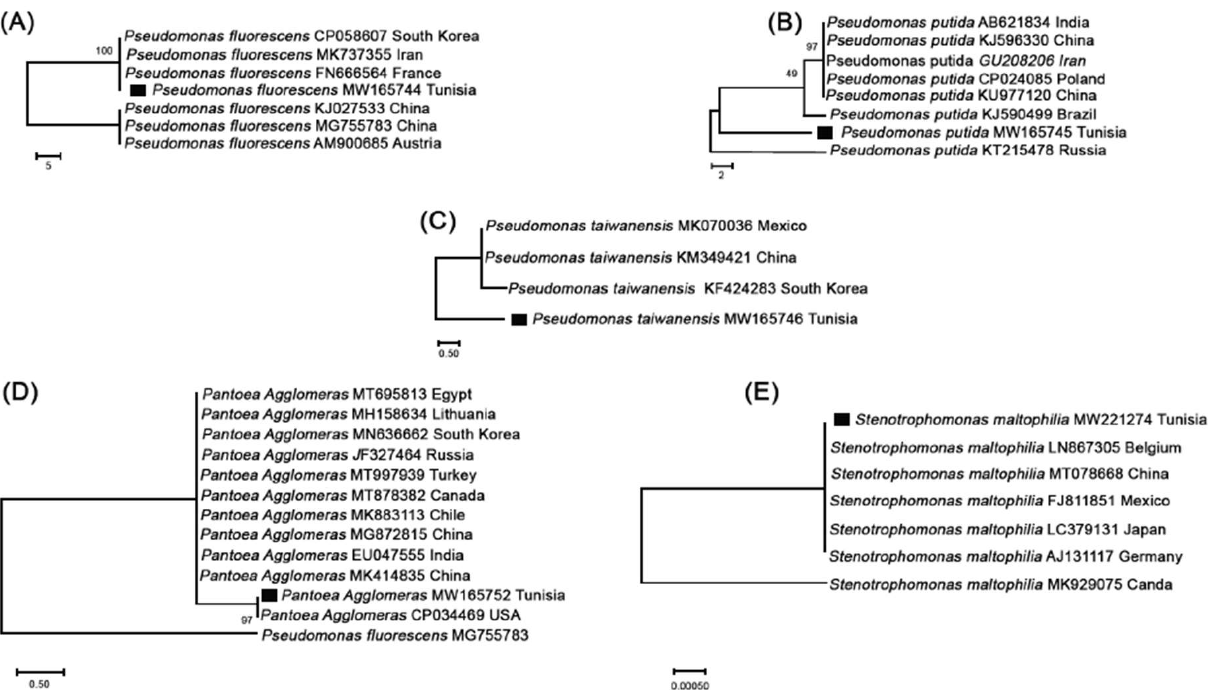
Figure 1. Partial sequence 16SrRNA gene phylogenetic tree of Pseudomonas ( A – C ), Pantoea agglomerans ( D ), and Stenotrophomonas ( E ) species. (Species described in this study are indicated with a black